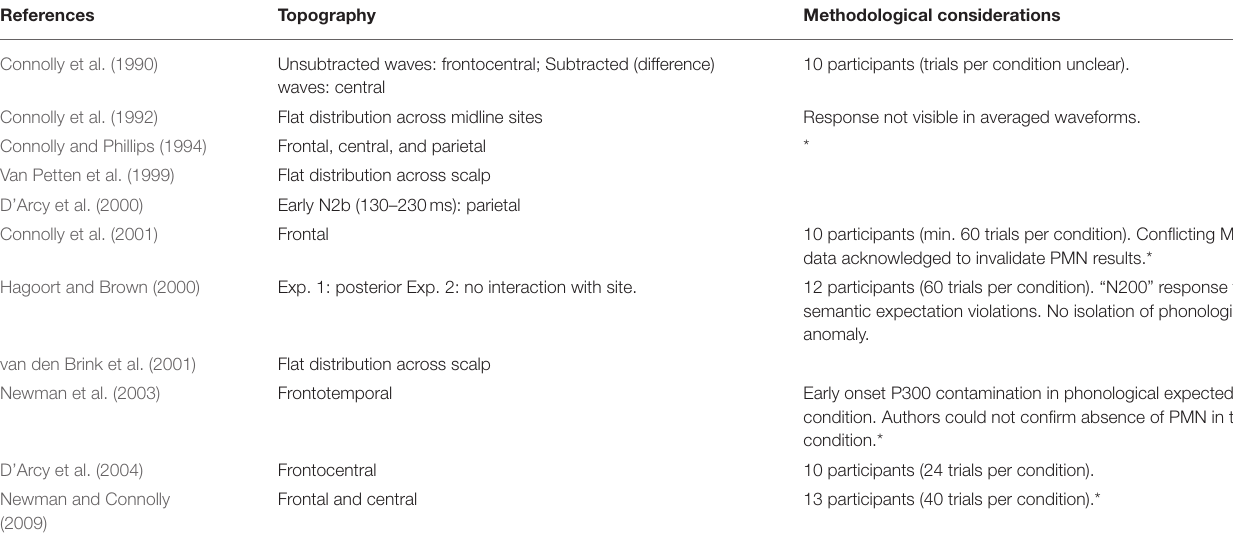
TABLE 1 | Summary of key studies charaterizing the PMN, reported effect topographies and methodological considerations.